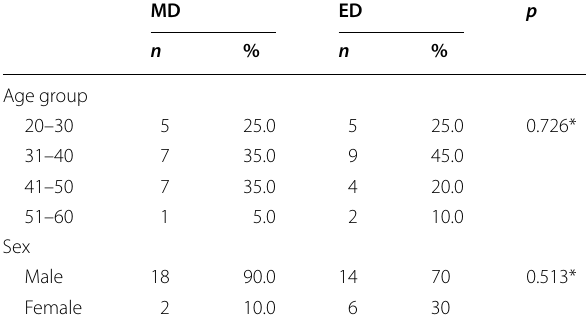
Table 1 Demographic data of the studied